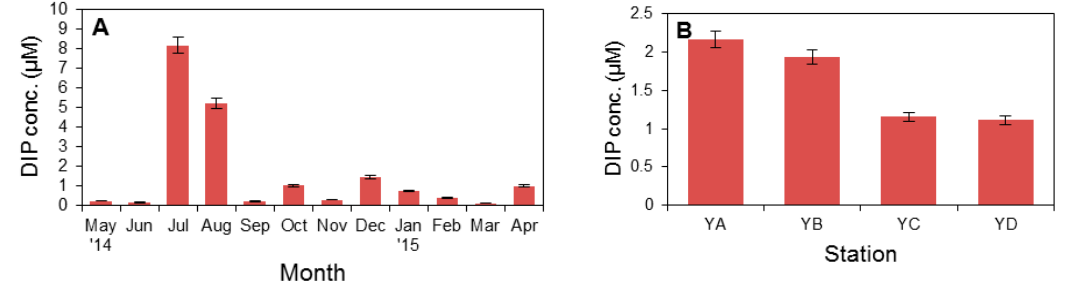
Figure 4. Average ( A ) monthly and ( B ) spatial variations of dissolved inorganic phosphate (DIP) concentrations in the upper Youngsan River estuary. Error bars represent standard deviations.